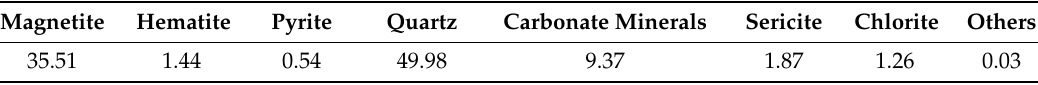
Table 2. Mineral composition of studied iron ore sample (mass fraction, %).